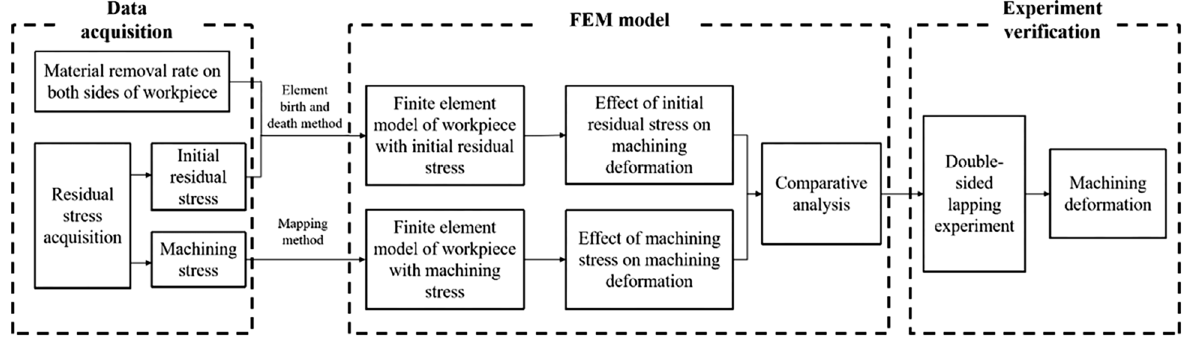
Figure 1 Schematic illustration of procedure of deformation analysis in double-sided